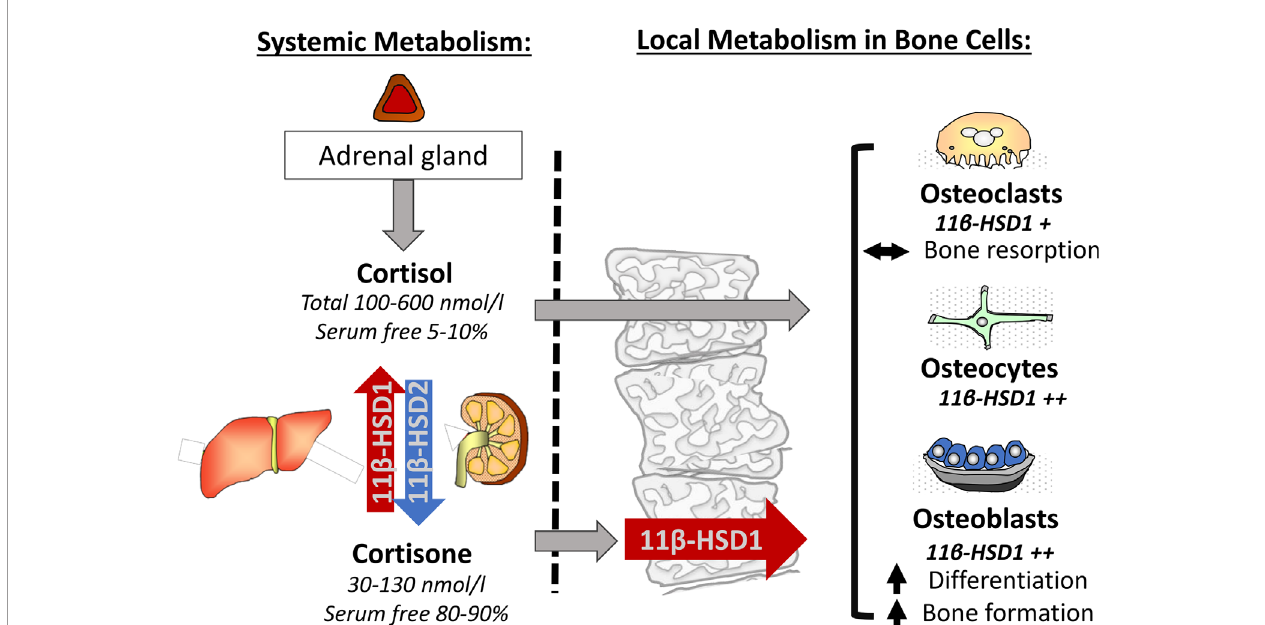
FIGURE 1 | The adrenal corticosteroids cortisol and cortisone achieve a circulating equilibrium predominantly through their renal inactivation by 11 b -HSD2 and reactivation by hepatic 11 b -HSD1. Both active and inactive serum free corticosteroids are able to enter bone cells. Here 11 b -HSD1 can further activate and amplify the actions of corticosteroids through the conversion of cortisone to cortisol where, in combination with serum free cortisol, it in fl uences basal bone metabolism in osteoclasts, osteocytes and